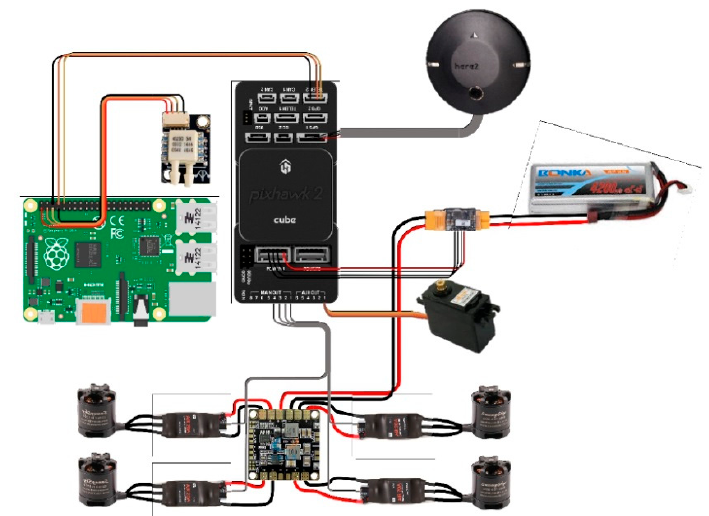
Figure 2. System configuration.